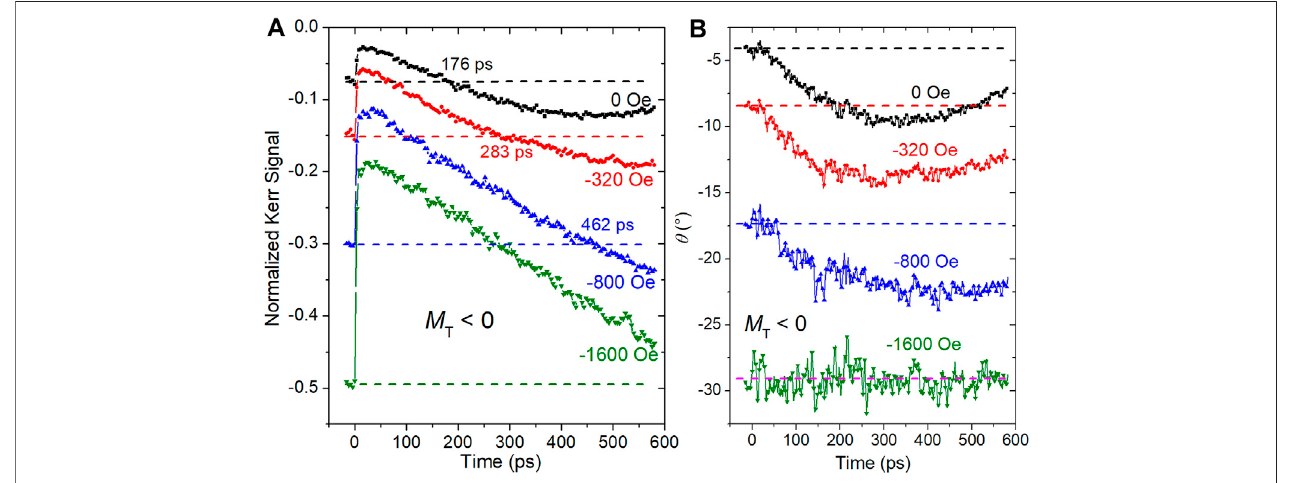
FIGURE 2 | (A) Laser-induced magnetization dynamics measured under different external fi eld and a constant pump fl uence of 9.8 mJ/cm 2 . (B) Average magnetization orientation angle θ as functions of delay time. The dashed lines in both (A) and (B) denote the initial state before excitation. The sign of M T shows the saturated state of the TbFeCo